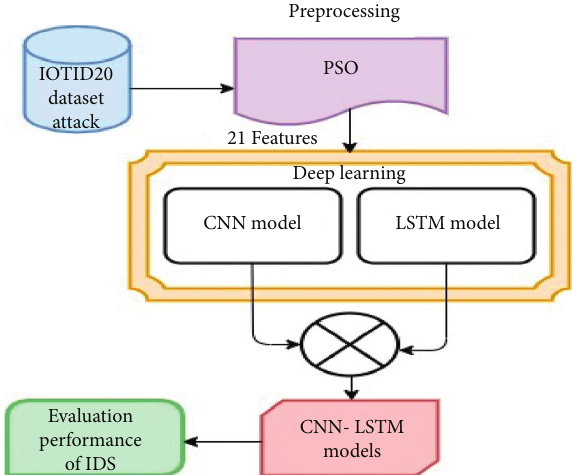
Figure 2: Generic framework of the proposed system.